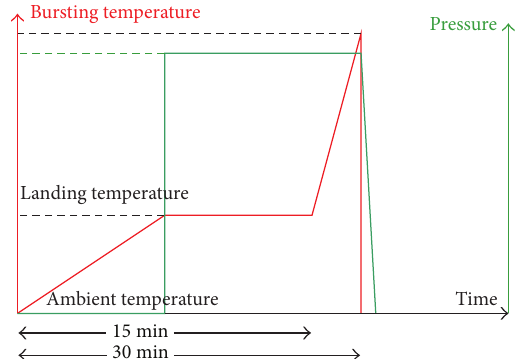
Figure 5: Principle of a bursting test.